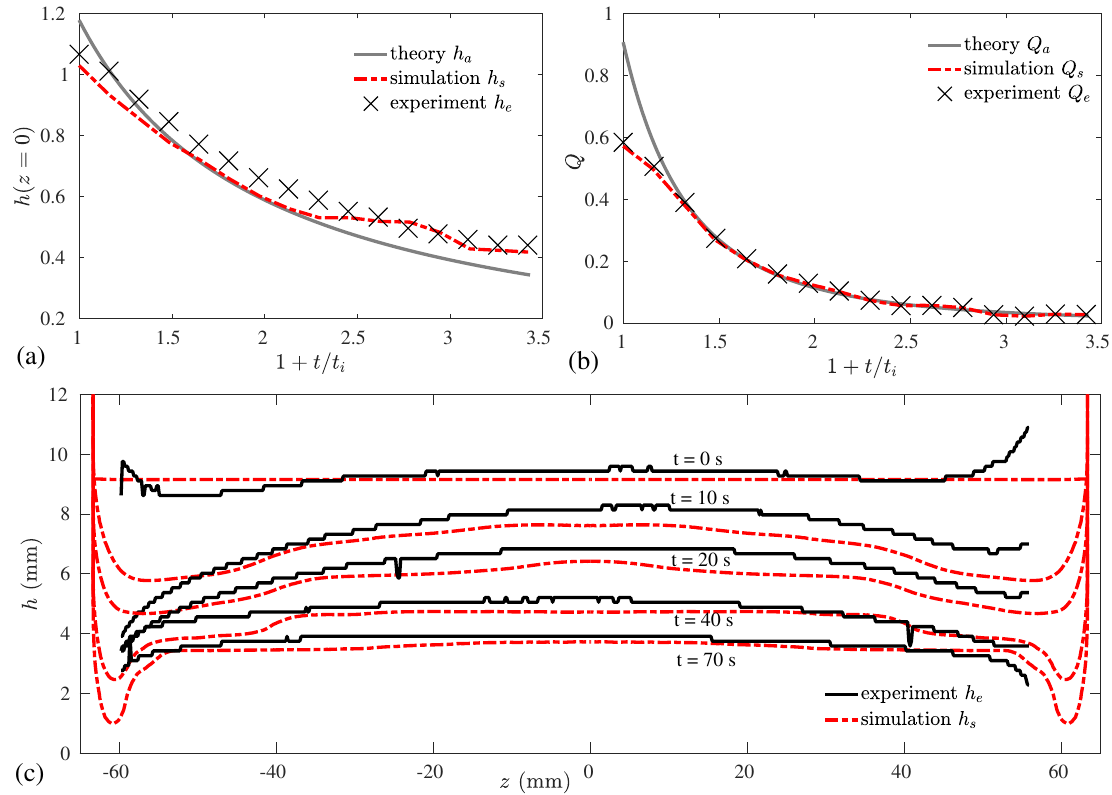
Figure 11. ( a ) h s (dashed), h a (8) (solid), and h e (ticks) plotted against time, ( b ) Q s (dashed), Q a (10) (solid), and Q e (ticks) plotted against time; ( c ) dimensional h s (dashed) plotted against h e (solid) at specified